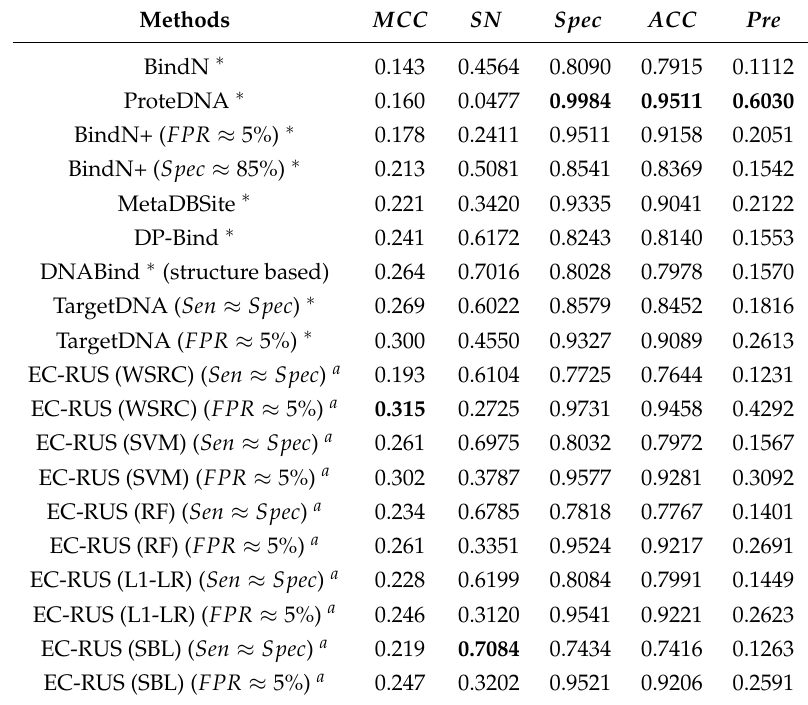
Figure 6. Results for different thresholds of probability on independent test set of PDNA-41. Rate p/n means the ratio between the predictive number of binding sites and the predictive number of non-binding sites. Table 4. Comparison with some state-of-the-art works on the Independent PDNA-41 dataset.